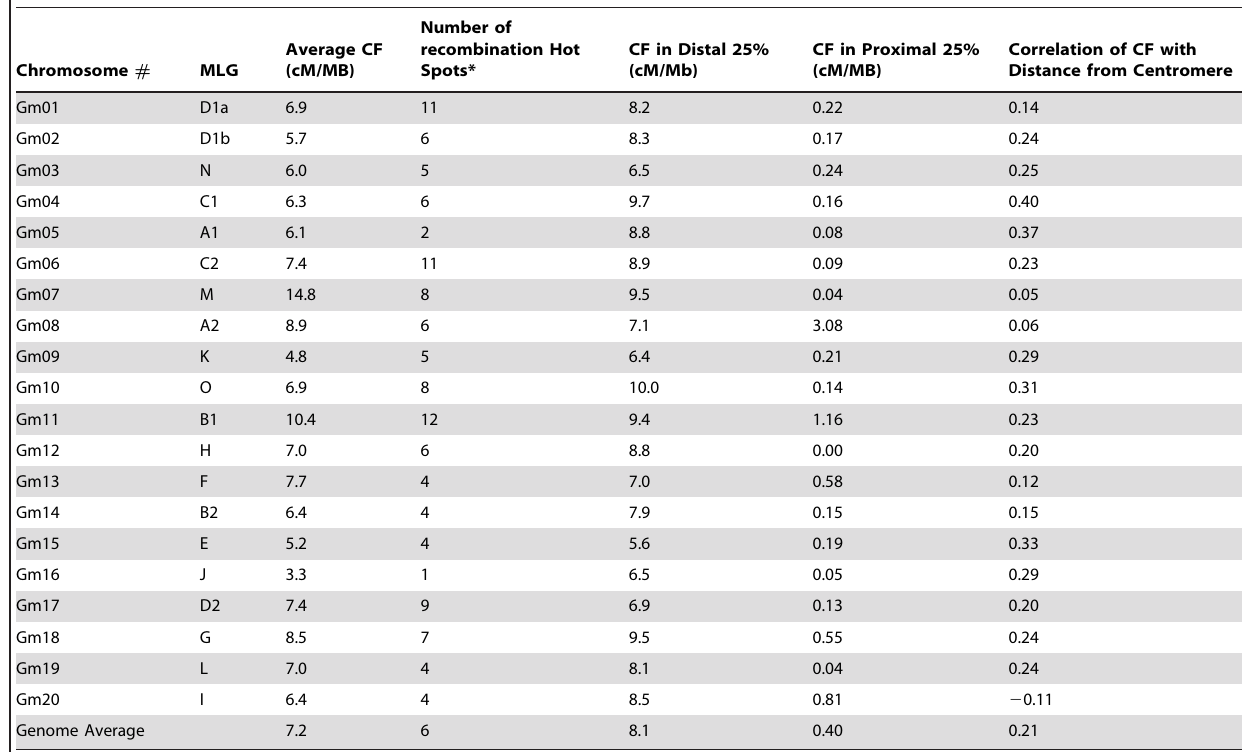
Table 2. Distribution of recombination on soybean chromosomes.